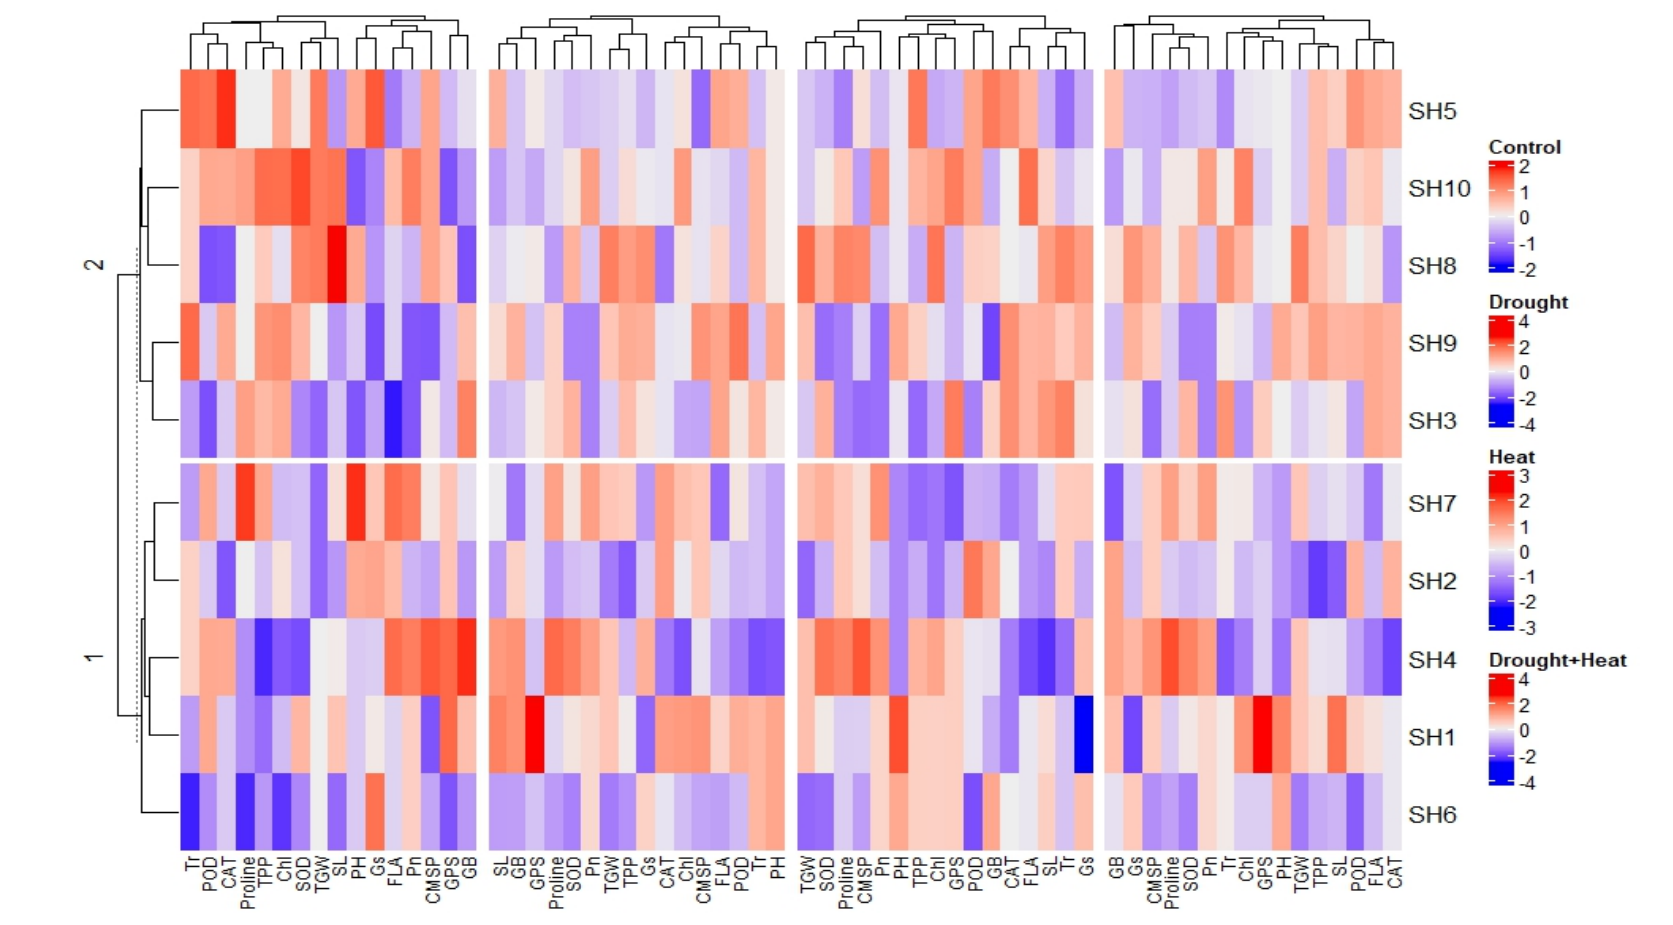
Figure 5. Heatmap dendrogram revealing varying extent of traits association in SH wheat genotypes due to control, separte, and combined regimes of drought and heat stresses. Pn; photosynthesis, Gs; stomatal conductance, Tr; transpiration rate, CMSP; cell membrane stability percentage, GB; glycine betaine, SOD; superoxide dismutase, POD; peroxidase, CAT; catalase, FLA; flag leaf area, PH; plant height, TPP; tiller per plant, SL; spike length, GPS; grains per spike, TGW; thousand grain weight.